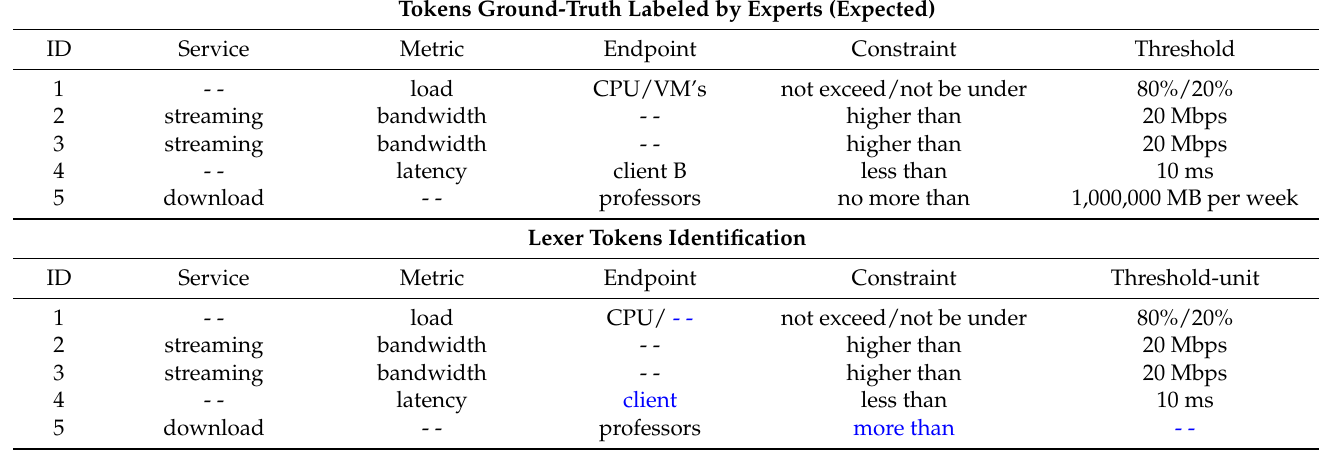
Table 2. Lexer tokens identification vs.